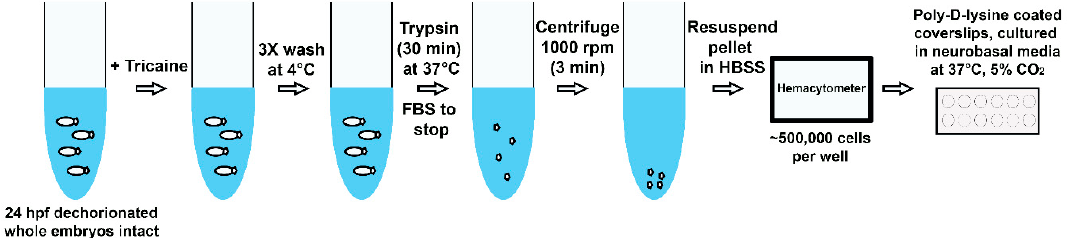
Figure 3. Summary of workflow for culturing zebrafish neurons. Embryos (24 hpf or 48 hpf) are collected, dechorionated, and placed in E3 medium and 16 µ M tricaine microtubes. Embryos are then washed three times with an ice-cold E3 medium before being placed in 1 trypsin (in PBS) and pipeted for 30 minutes intermittently in a 37 ◦ C water bath. To stop separation, fetal bovine serum (FBS) is then added and the tubes are centrifuged at 1000 rpm for 3 minutes. The supernatant is removed, and cell pellet resuspended in Hanks’ balanced salt solution (HBSS). Cells are counted using a hematocytometer, and ~500,000 cells are placed per well for culturing. It is recommended to change half of the media daily. (hpf: hours post fertilization)